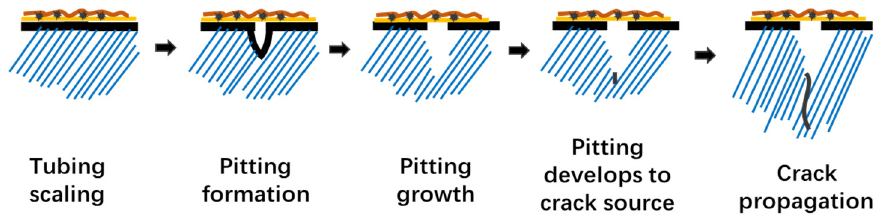
Figure 15. Development Process of Tubing Fracture Failure Caused by Corrosion under Scale.